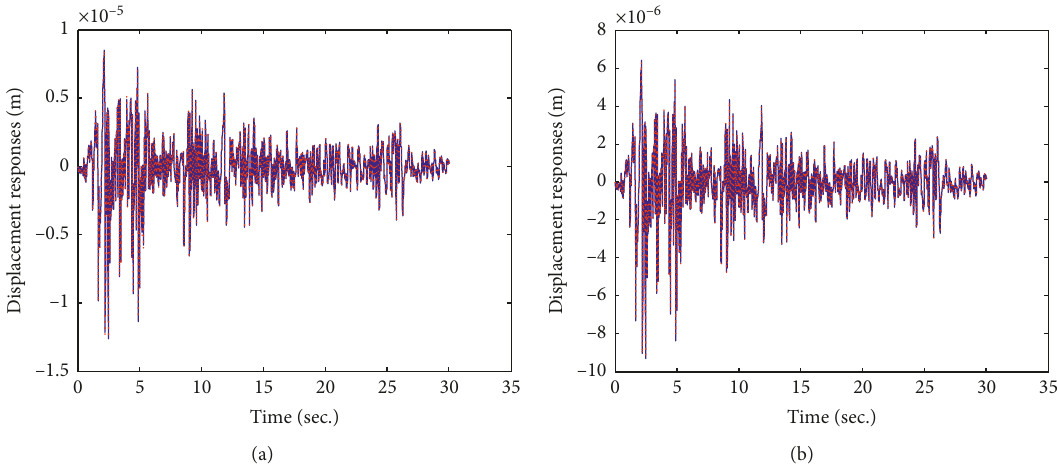
Figure 11: Comparison of displacement responses of cases 1 and 2. (a) Displacement responses at node 10; (b) displacement responses at node 15.